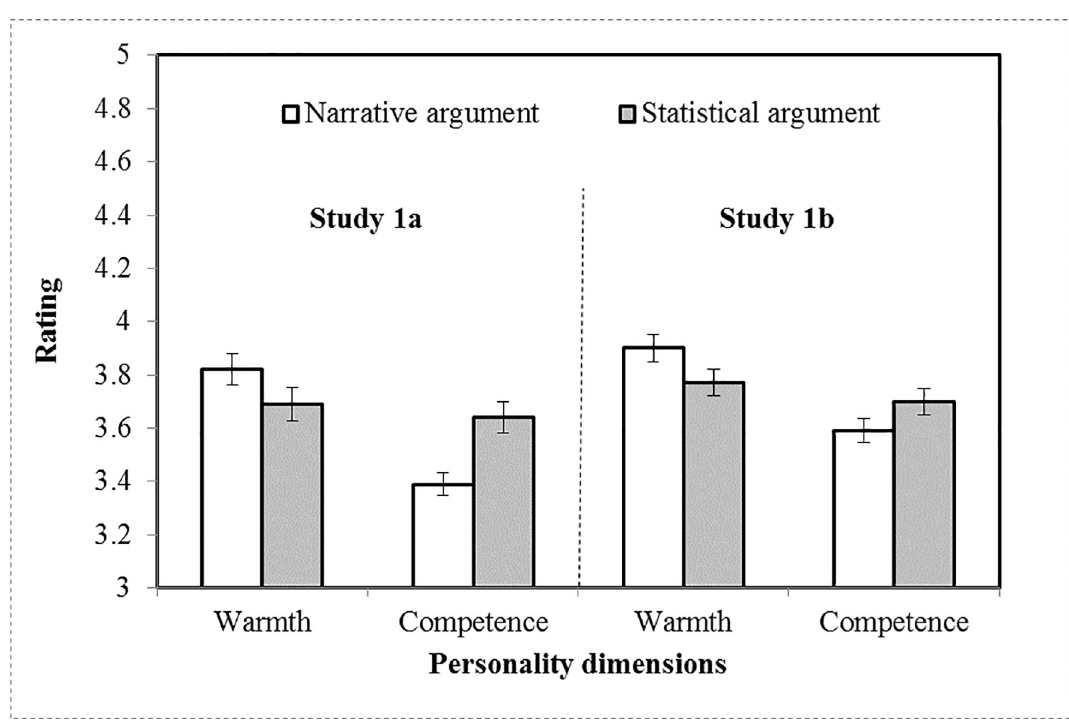
Fig 2. Mean warmth and competence ratings of a source using narrative vs. statistical argumentation across Studies 1a and 1b. Note . Error bars represent standard